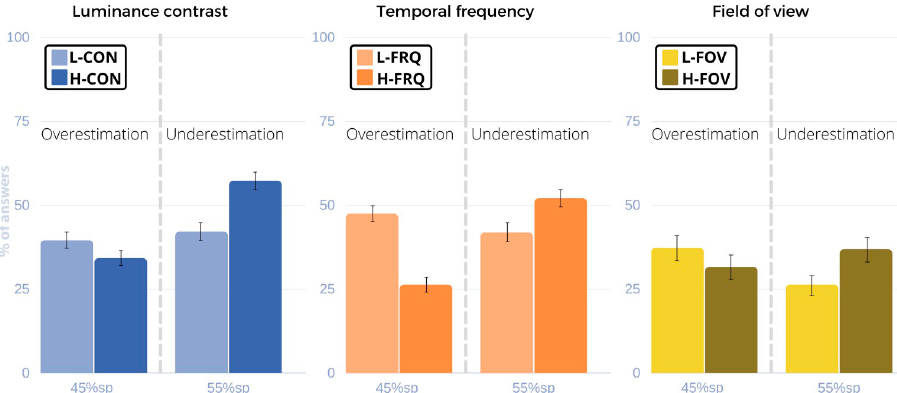
Fig 3. Results for Experiment 1. From left to right: Aggregation of trials by luminance contrast, temporal frequency and field of view conditions. Y axis: % of answers. X axis: 45% and 55% sampling points (sp). The displayed bars of each graph correspond to p over,45 at the 45% sp (overestimation) and to p under,55 at the 55% sp (underestimation). The percentage of correct answers for each case is complementary to the displayed value in the graph (p corr,45 +p over,45 = 100% and p corr,55 +p under,55 = 100%). Note that overestimation is always more frequent in low magnitude levels and underestimation in high magnitude levels, regardless of the visual feature.